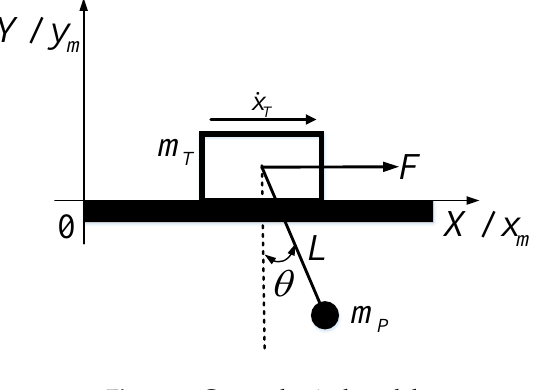
Figure 1. Crane physical model.